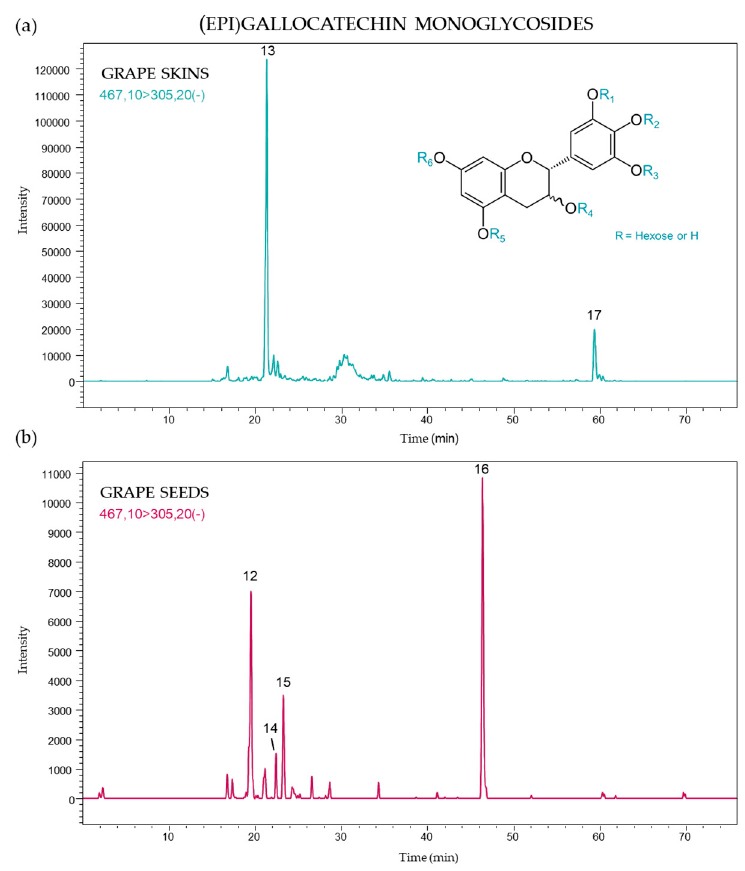
Figure 3. (Epi)gallocatechin monoglycoside profile of ( a ) skins and ( b ) seeds from Vitis vinifera grapes using MRM [467 → 305].